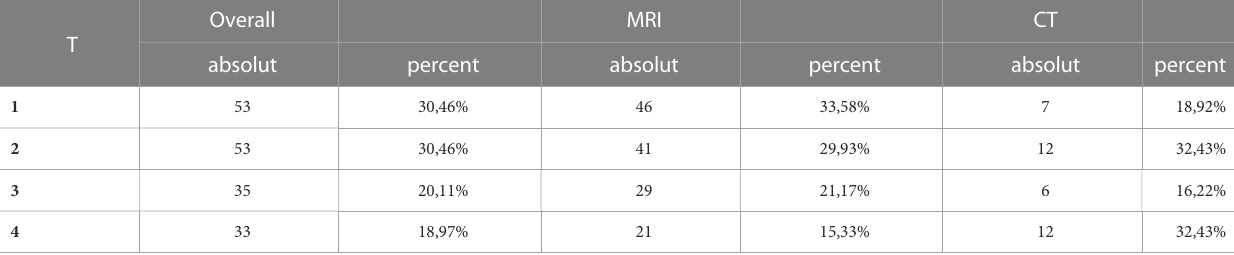
TABLE 3 cT status of 174 patients according to MRI, CT and overall groups.